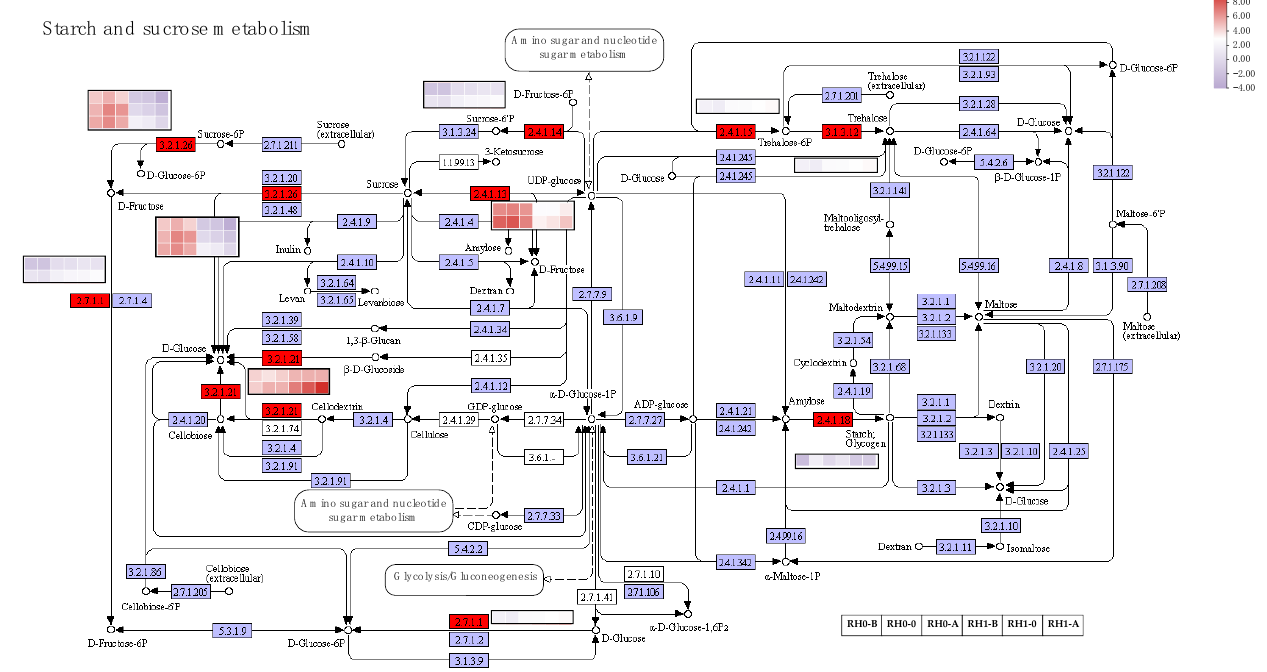
Figure 6. Expression pattern of key DEGs in sugar metabolism pathway at different development stage of two-type roots in A. beshanzuensis